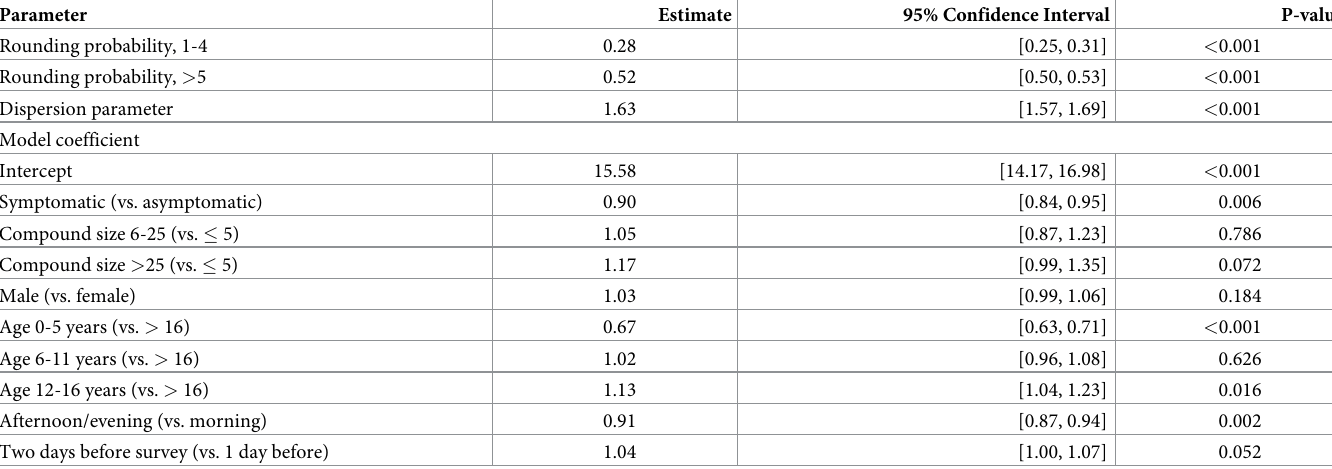
Table 3. Estimates for coefficients, dispersion parameter, and rounding probabilities for the degree model.